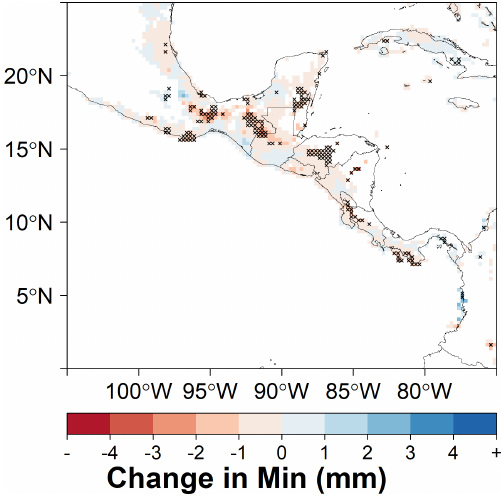
Figure A5. The change in MSD minimum between the early (1981– 2000) and late (2001–2020) periods. Grid cells marked with an “X” show statistically significant changes.